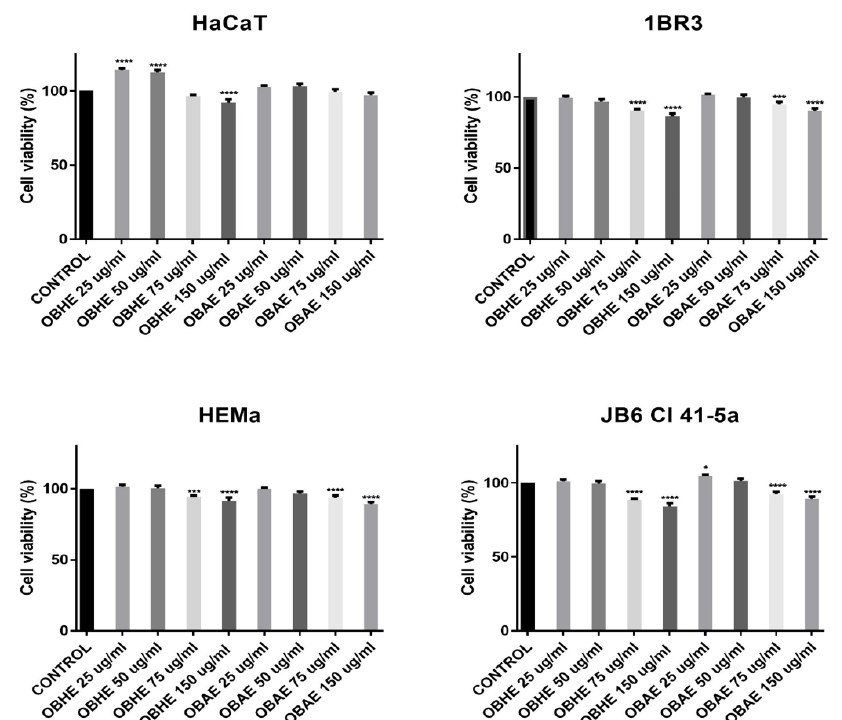
Figure 2. Viability percentage of HaCaT, 1BR3, HEMa and JB6Cl41-5a cells after stimulation with basil hydro-alcoholic extracts (25, 50, 75 and 150 μg/mL), at 24 h post-stimulation. The results are